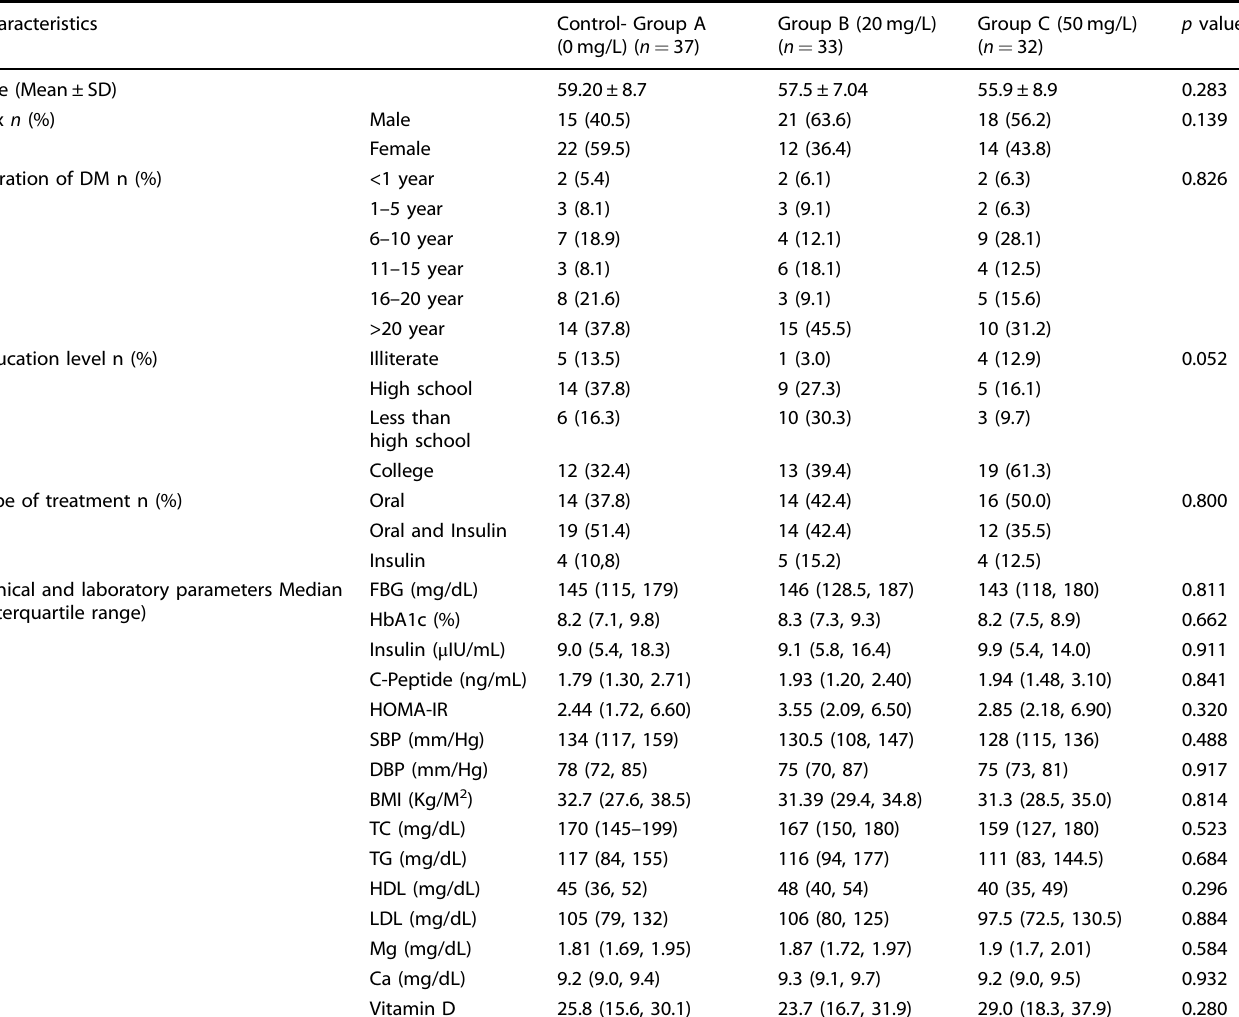
Table 1. Baseline characteristics of the participants who successfully completed the study.